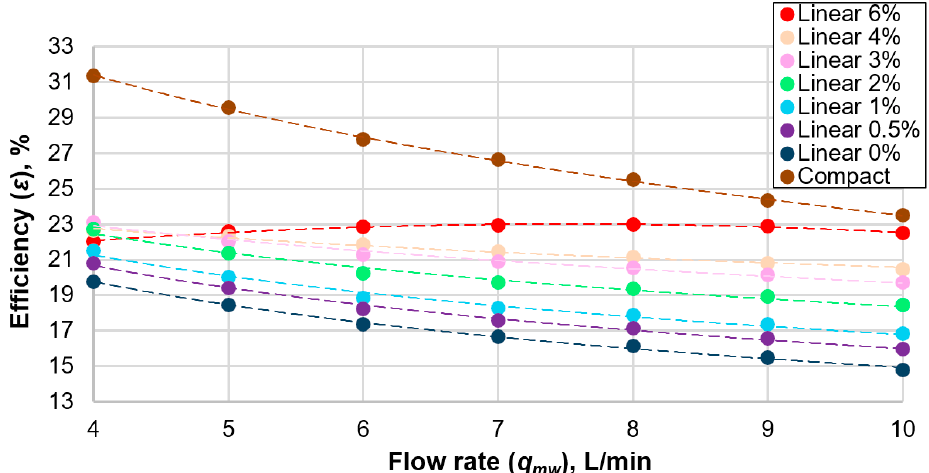
Figure 6. Efficiency of the shower heat exchangers determined for T cw = 12 °C.